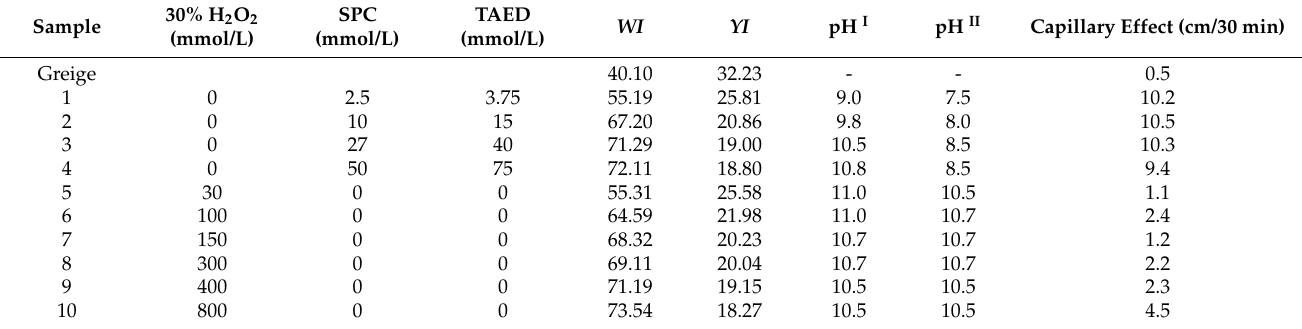
Table 1. Comparisons of the scouring and bleaching performances between the two